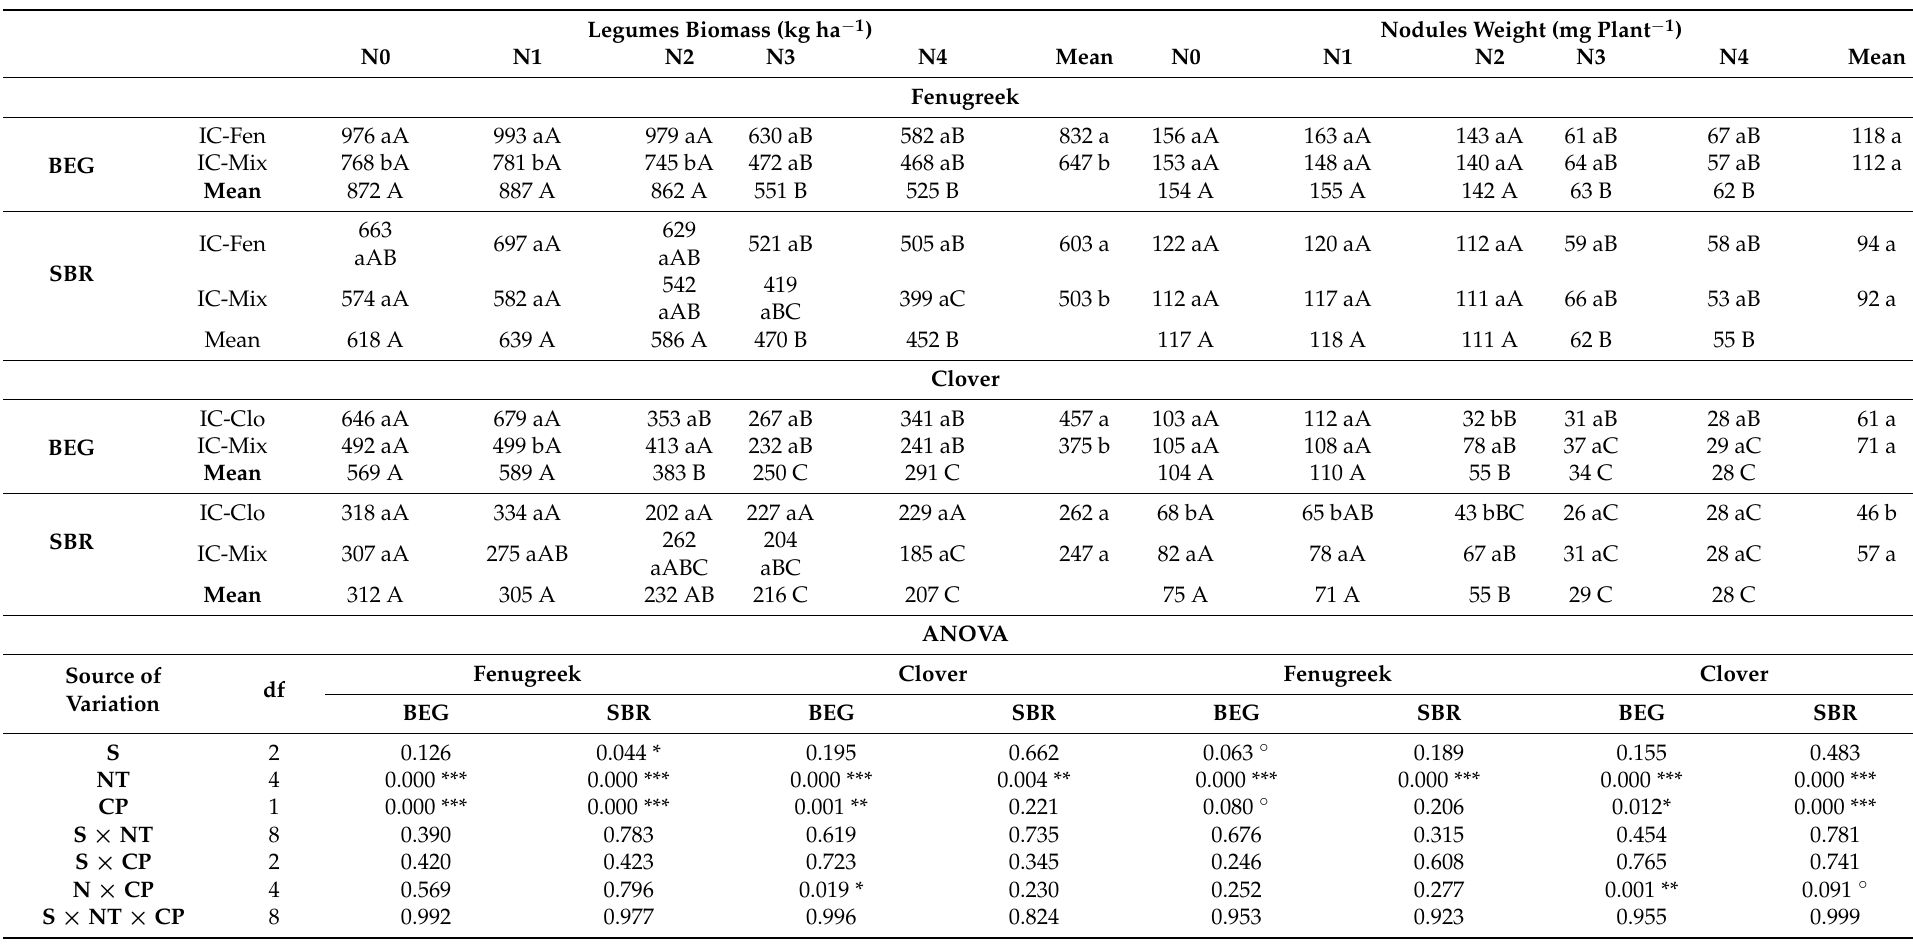
Table 1. Effects of cropping pattern and N-treatment on legumes biomass and nodule fresh weight at both sites averaged across the three experimental